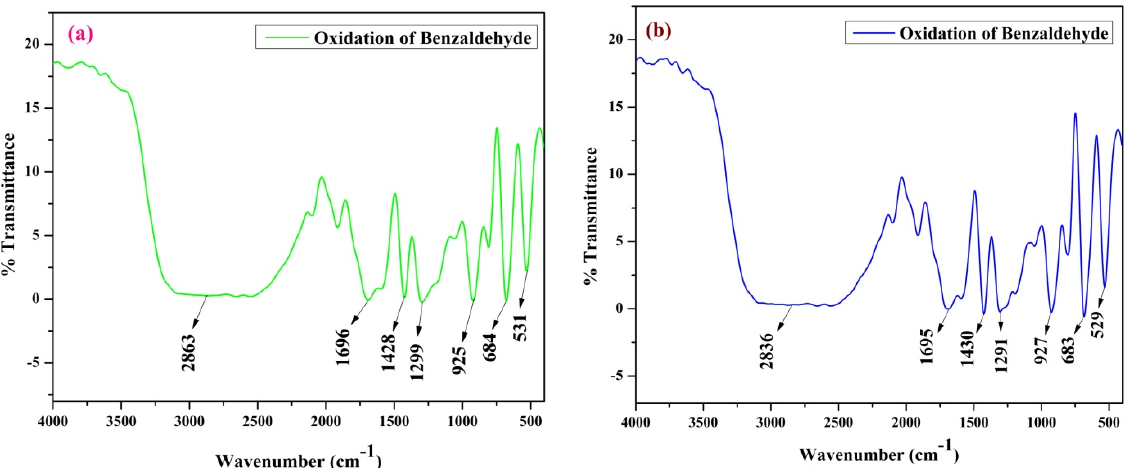
Figure 6. FTIR analysis of the oxidation of benzaldehyde to benzoic acid by TiO 2 nanoparticles: ( a ) without catalyst and ( b ) with catalyst.